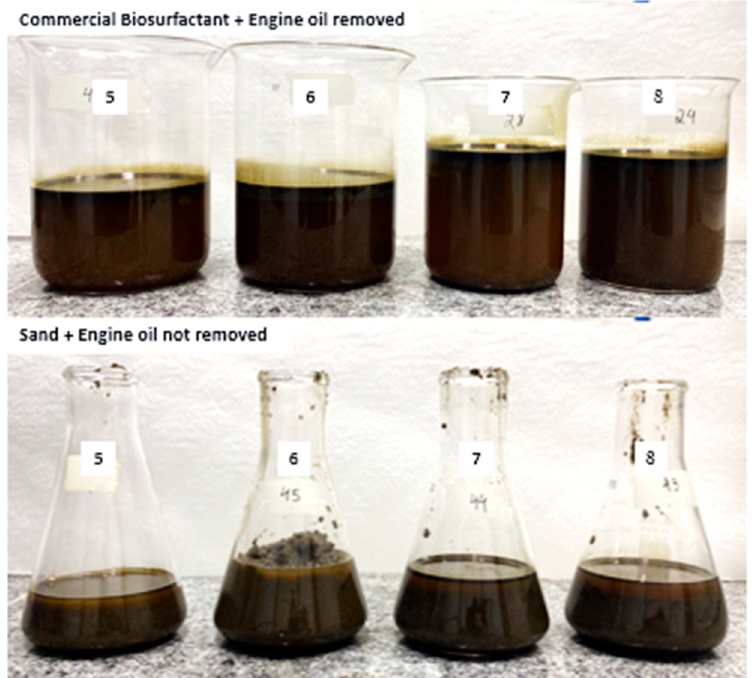
Figure 14. Images of washing solutions containing commercial surfactant ( top ) and sand ( bottom ) after axial runs of contaminant removal carried out according to the Central composite rotational design (CCRD) design. Numbers (5–8) correspond to experimental runs.